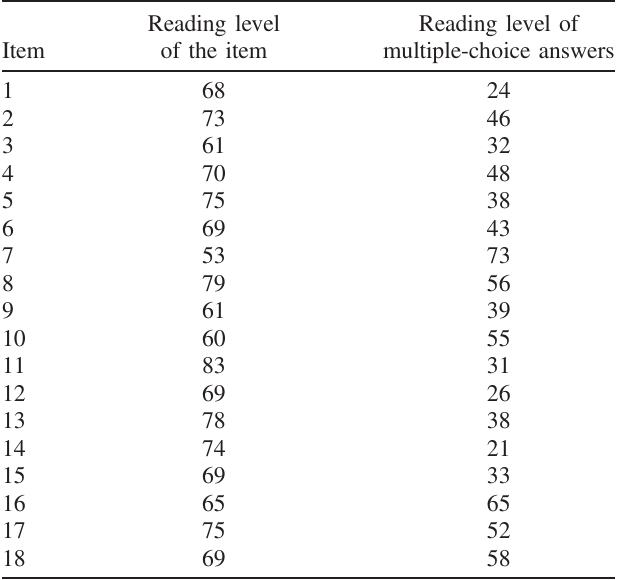
TABLE III. Reading level of 18 items and multiple-choice answers contained in the MPCI-MS as measured with the online tool Scolarius. Elementary reading level: 50 – 89; High school: 90 –